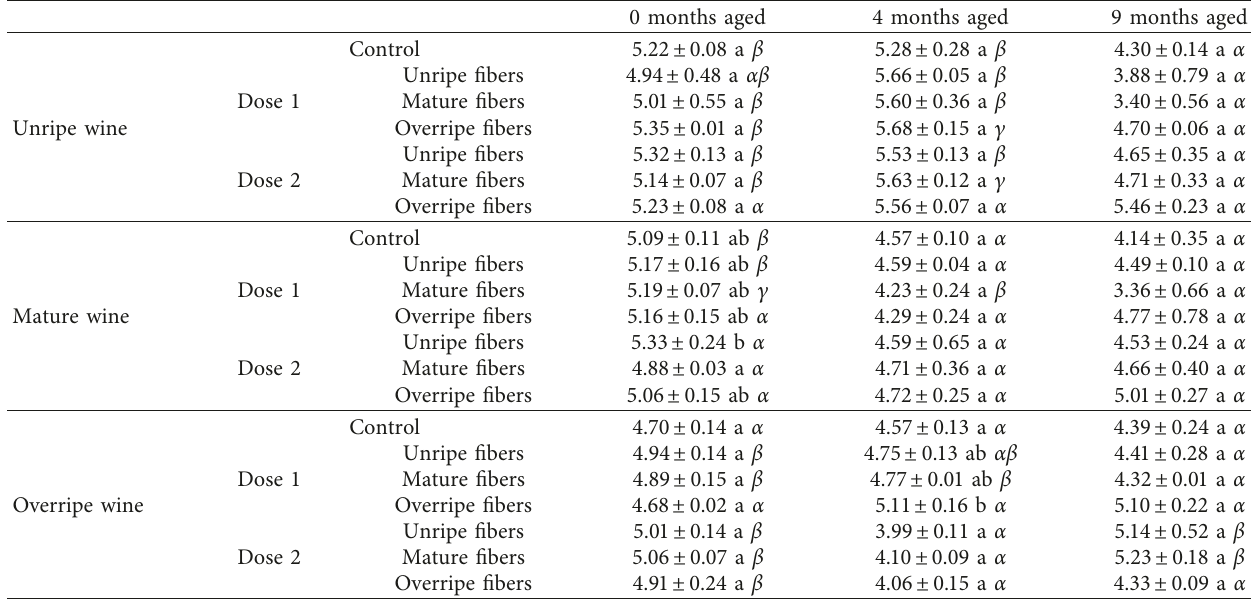
Table 10: Mean degree of polymerization (mDP) of the wine